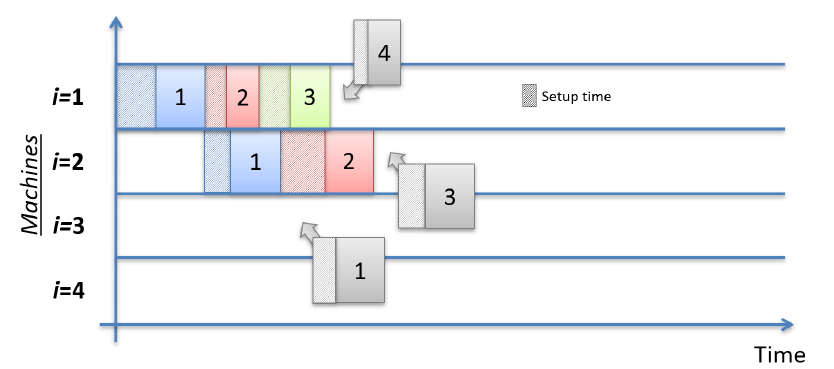
Figure 2. Example of operations that are waiting to be processed.